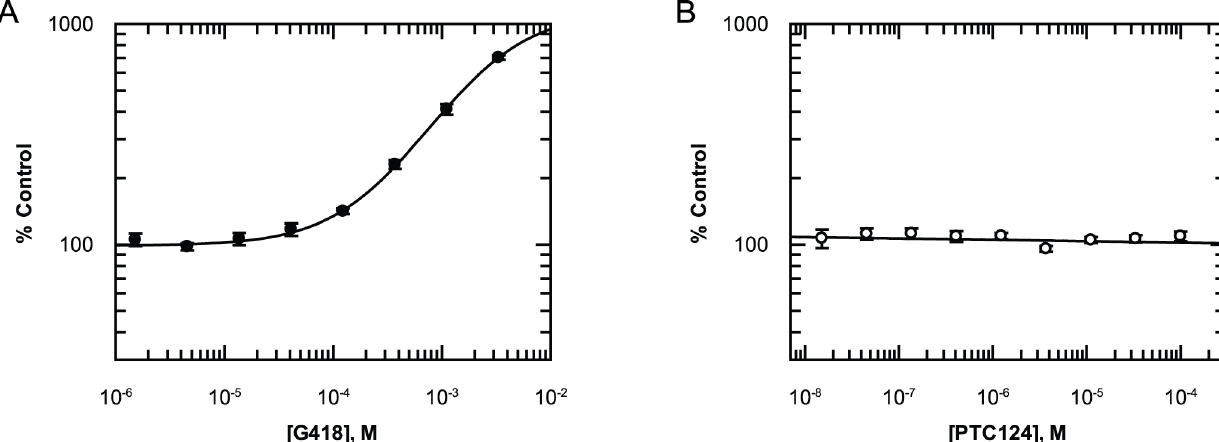
Figure 2. Lack of PTC124 efficacy with a stably expressed b -Galactosidase PTC-reporter. (A) Incubation with G418 for 24 hours leads to a dose-dependent increase in enzyme activity of stably transfected PTC- b -Gal. (B) 24-hour incubation with PTC124 at concentrations in excess of its